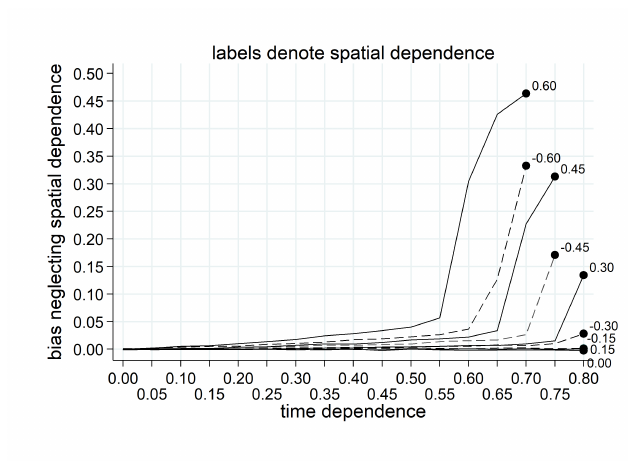
Figure 1: Bias of Team Dynamic neglecting the spatial dimension. The vertical axis describes γ the horizontal axis depicts γ 0 . Labels denote spatial dependence in the DGP ( λ 0 ).